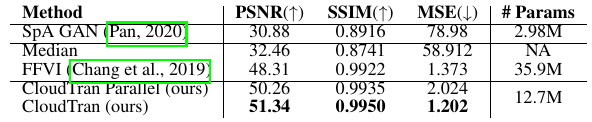
Table 5. Comparison with cloud removal baselines for 256 × 256